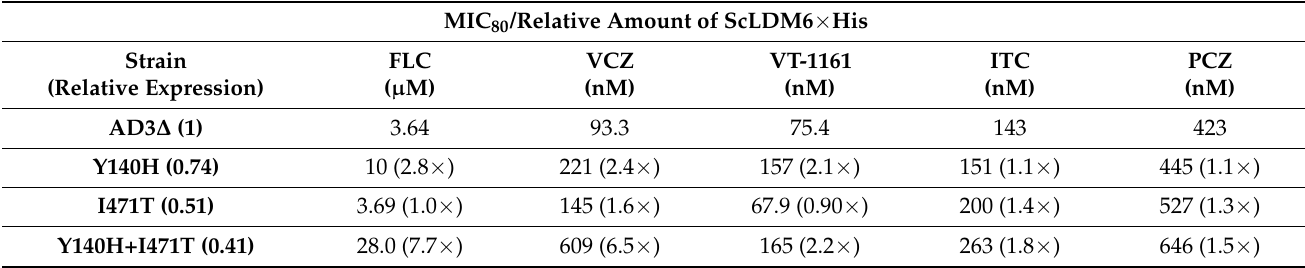
Values from Table 1 are normalized relative to the amount of ScLDM6 × His in crude membrane preparations from each strain (parenthesis in bold), detected using an anti-His tag antibody relative to strain AD3 ∆ (Figure 2b). The values in parenthesis indicate the fold-resistance of each recombinant strain based on the relative amount of recombinant enzyme in crude membrane preparations compared with strain AD3 ∆